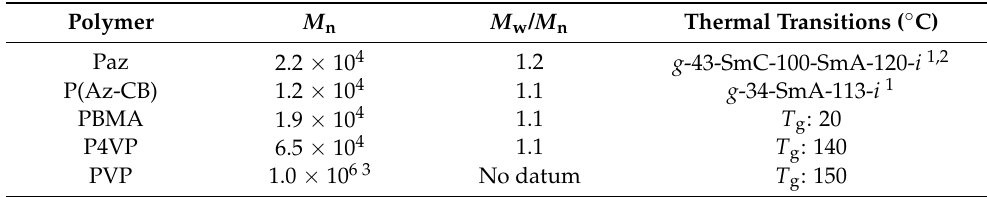
Table 1. Molecular mass data of the polymers.